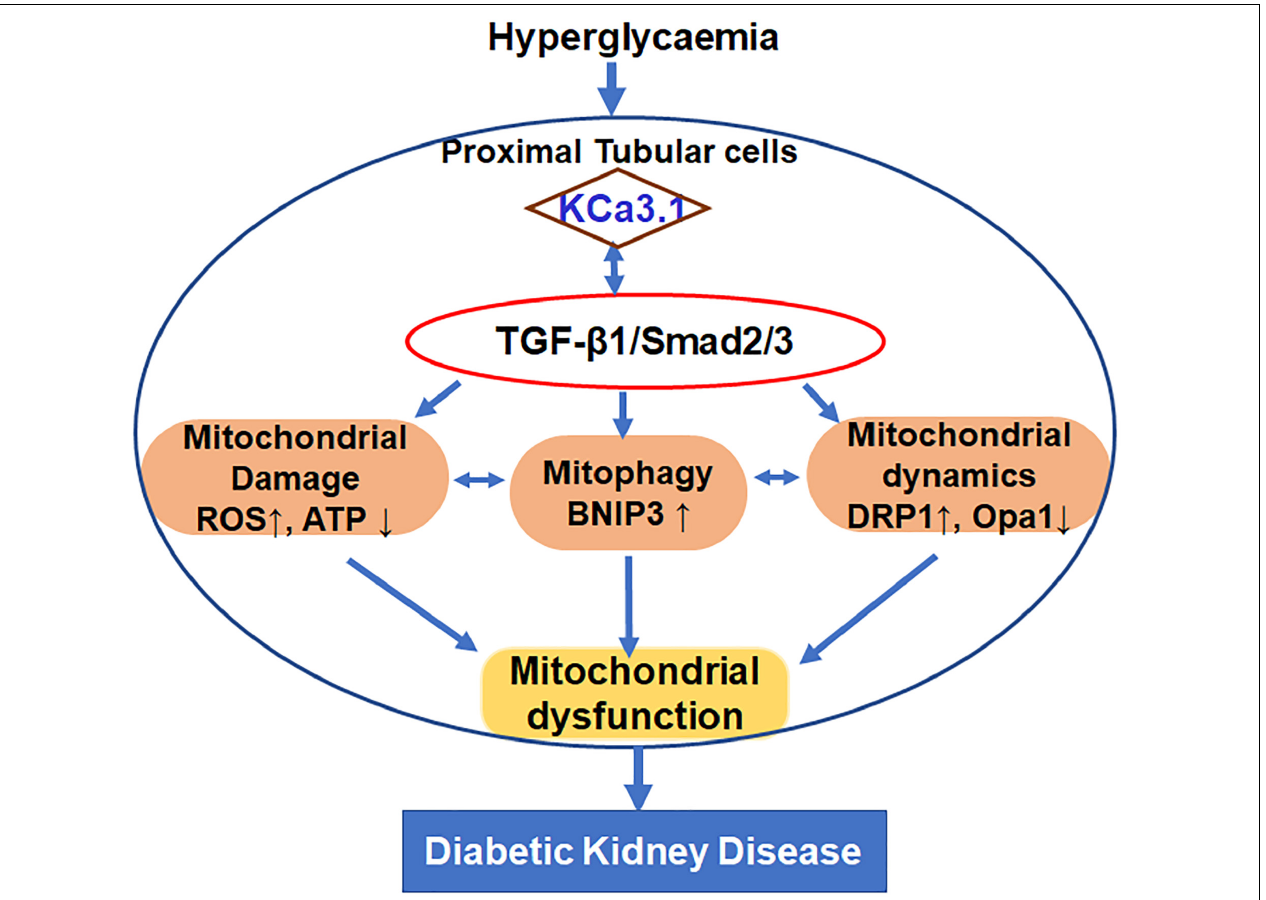
FIGURE 7 | Schematic diagram depicting the conceivable cellular events by which KCa3.1 mediates dysregulation of mitochondrial quality control in diabetic kidney